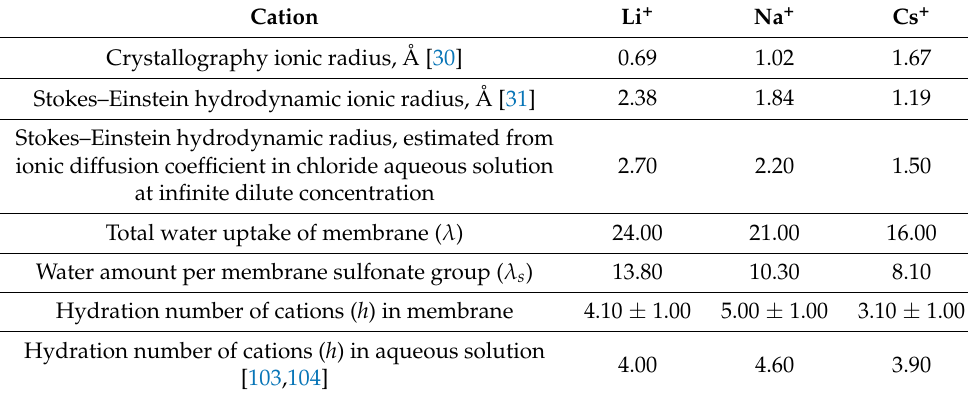
Table 5. Crystallography radii, Stokes–Einstein hydrodynamic ion radii, hydration numbers ( h ) of Li + , Na + , and Cs + cations in appropriate MSC membrane ionic forms at RH = 95% and in equimolar aqueous salt chloride solutions [17].